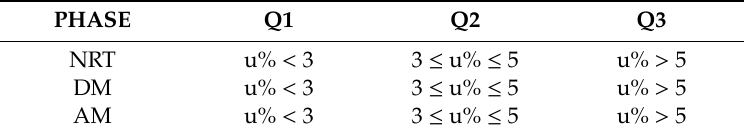
Table 8. Examples of data quality levels as a function of the data